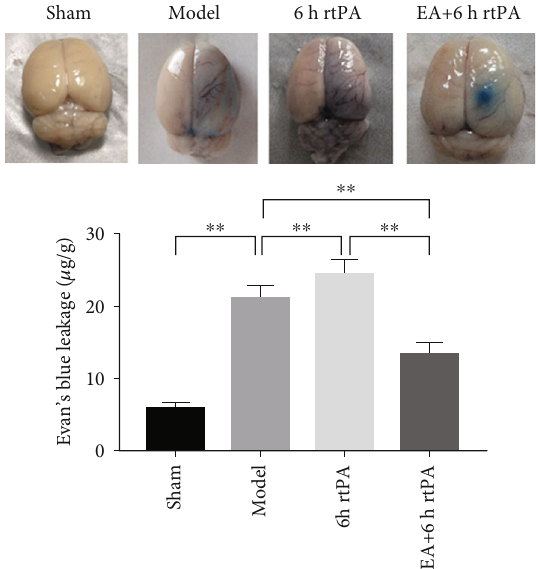
Figure 3: BBB permeability in each group ( n = 6 rats). ∗∗ indicates p < 0 : 01